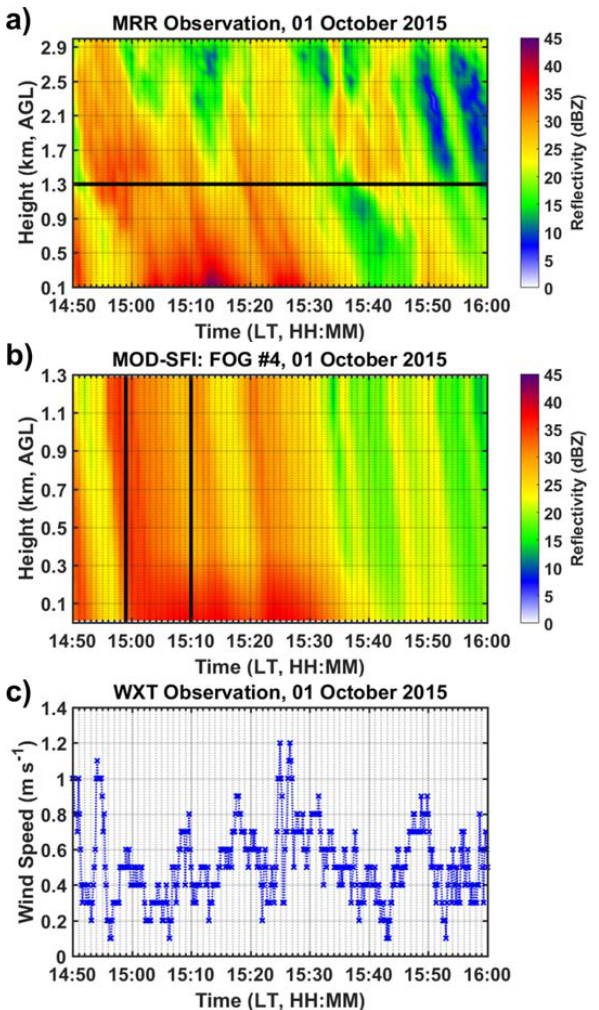
Figure 7. Time series of observed reflectivity ( a ) from the MRR, simulated reflectivity ( b ) with the presence of fog (FOG #4, see its spectrum in Figure 6 a ) during 15:00–15:30 LT, and surface wind speed ( c ) observed by the weather station (WXT). The black horizontal line in ( a ) marks the top boundary level at 1.3 km AGL. The black vertical lines in ( b ) mark 14:49 LT and 15:10 LT, which will be discussed in later figure.